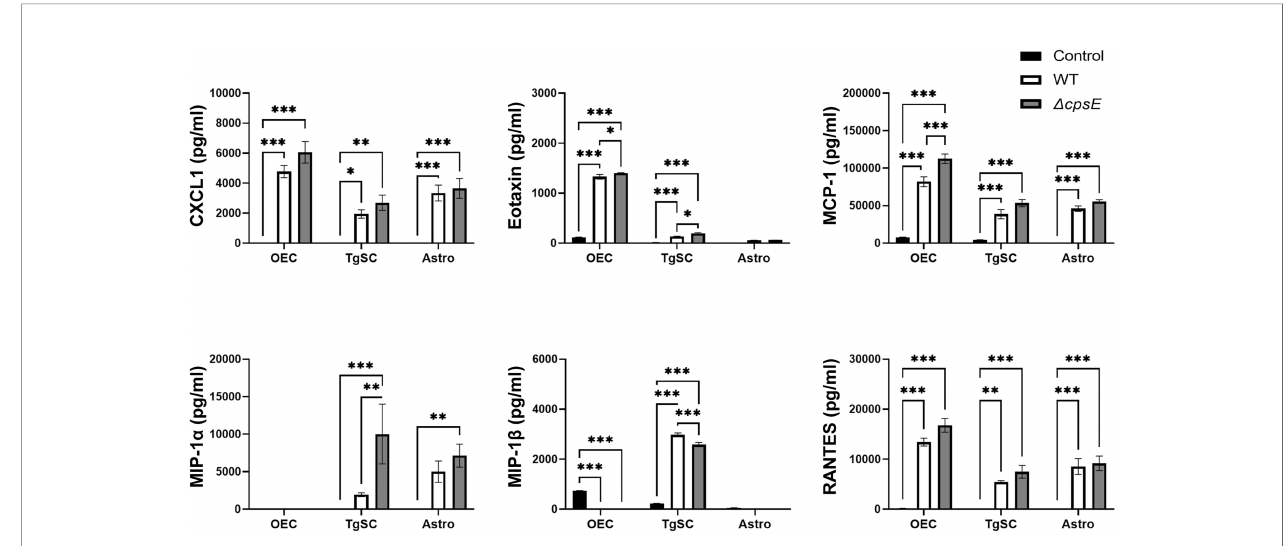
FIGURE 10 | Chemokine responses in glia after inoculation with wild-type and capsule-de fi cient S. agalactiae . OECs, TgSCs and astrocytes were inoculated with either WT or D cpsE (MOI 100:1) after which the chemokine levels in the medium were analysed at 24 h post inoculation. Data show mean ± SEM, *p ≤ 0.05, **p ≤ 0.01, ***p ≤ 0.001 (two-way ANOVA with Tukey ’ s multiple comparison test, n = 3 technical replicates x 100,000